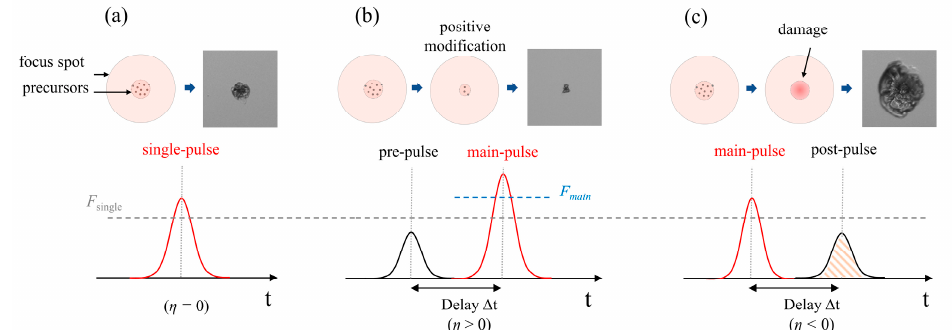
Figure 11. Schematic of a dual pulse acting on fused silica with temporal shaping. ( a ) Single pulse ( η = 0); ( b ) the ramp-up shape with the pre-pulse ( η > 0); ( c ) the ramp-down shape with the post-pulse ( η > 0).